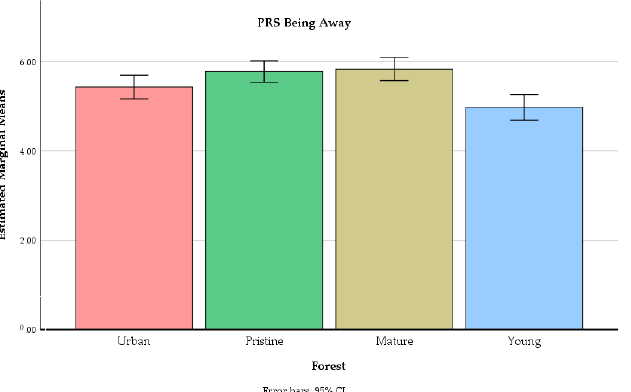
Figure 5. The mean values of PRS being away in four different forests at the end of the experiment. Error bars represent 95% confidence intervals.